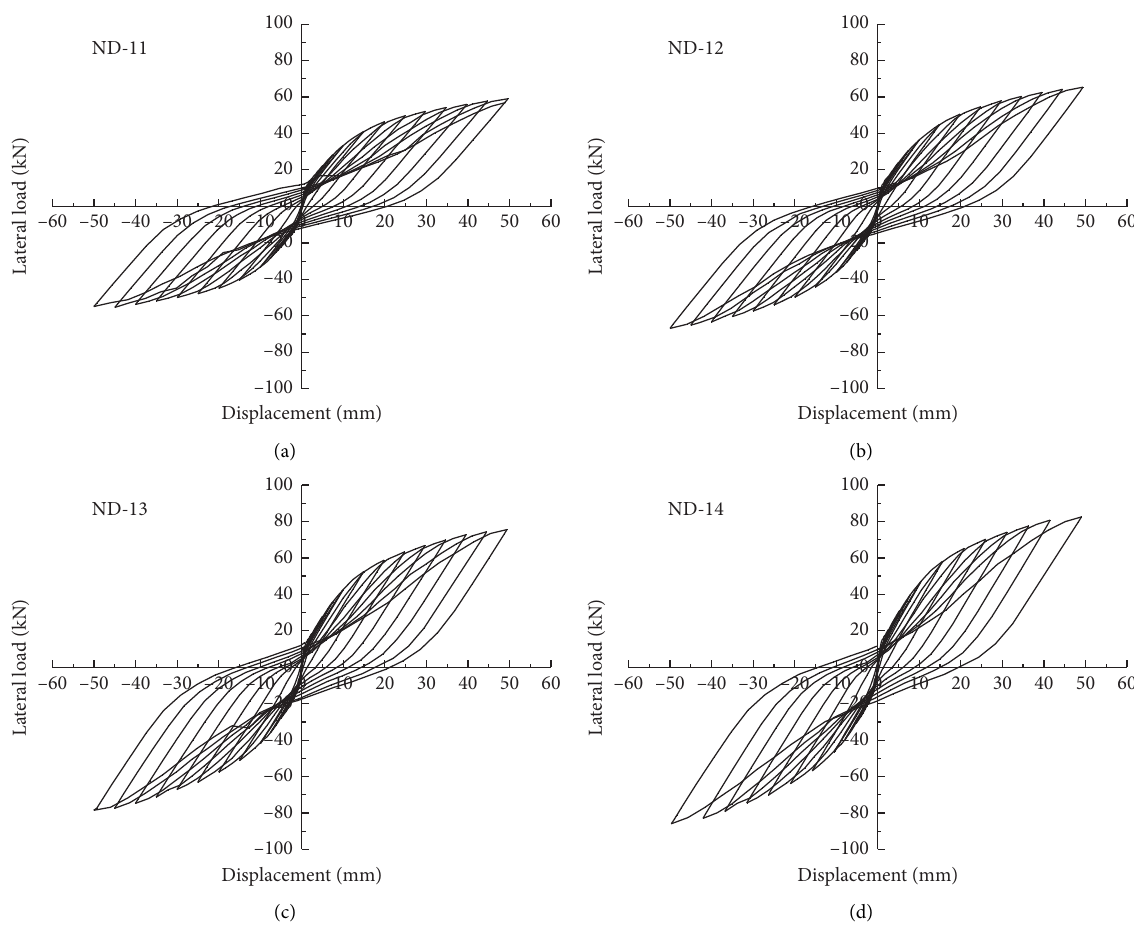
Figure 21: Hysteretic curves of slit width 60mm. (a) 30MPa. (b) 40MPa. (c) 50MPa. (d) 60MPa.